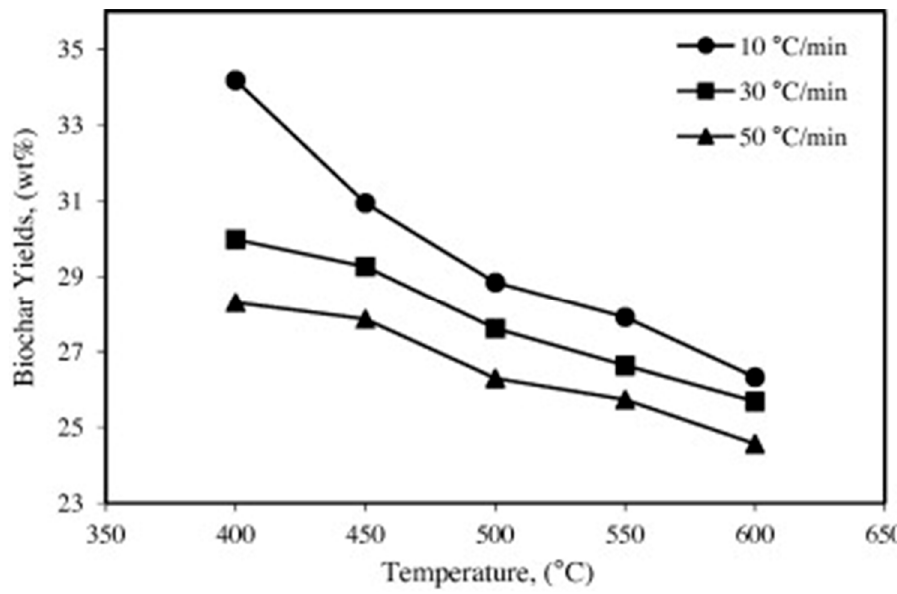
Figure 4. Effect of temperature and heating rate on char yields from safflower seed cake. (Reprinted with permission from ref. [24]. Copyright 2013 Elsevier.)